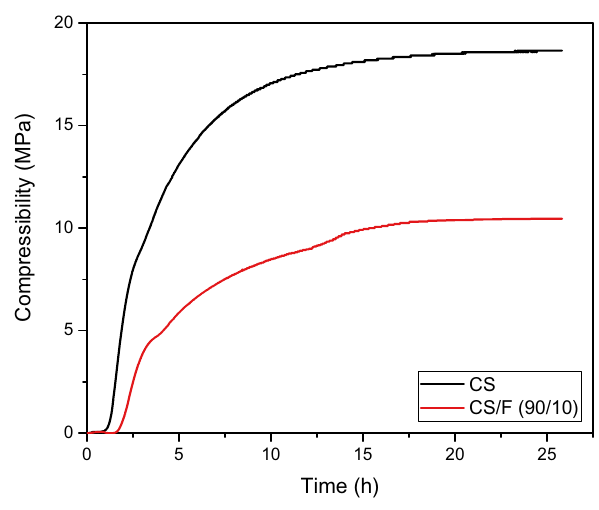
Fig. 8 Compressive strength curves for cement slurry (CS) and cement slurry (CS) contaminated with flushing fluid (CS/F), in the proportion 90/10